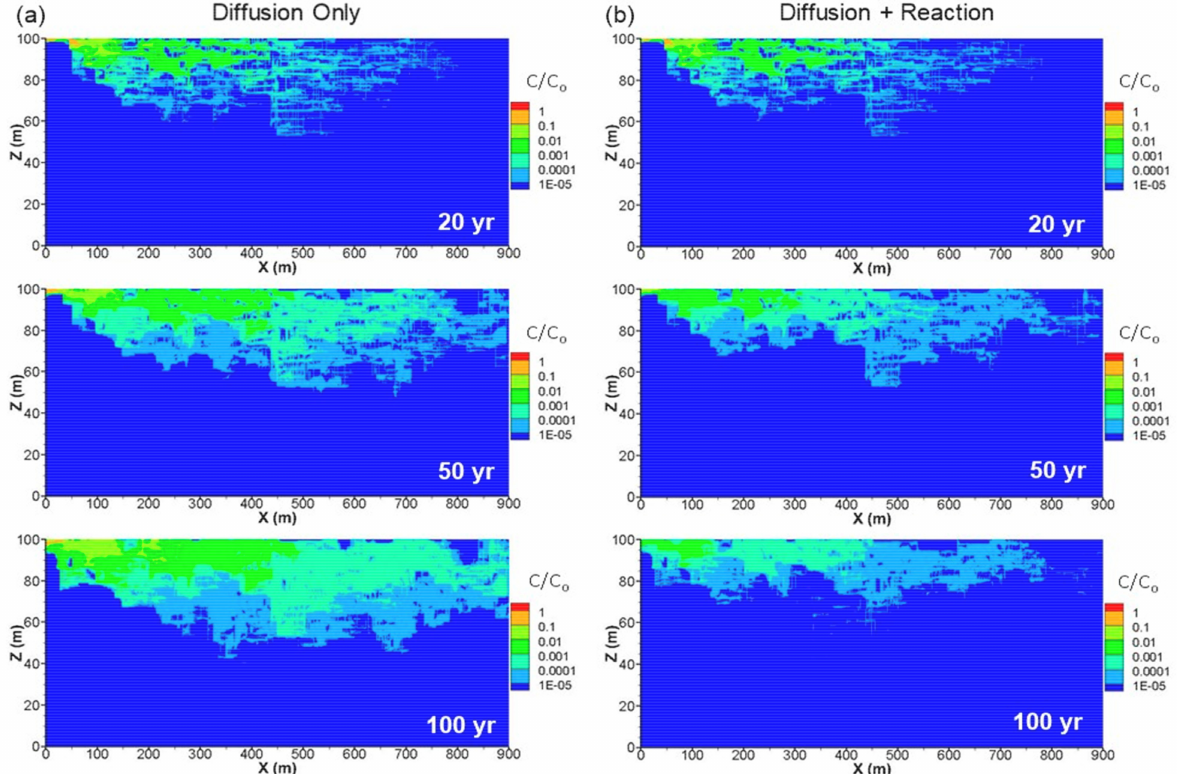
Figure 10. DFM simulated plumes at 20, 50 and 100 years for conditions of ( a ) diffusion only, and ( b ) diffusion and reaction that represents Cr ( VI ) loss in the matrix due to precipitation (simplified as first-order decay with t 1/2 = 20 years). The source is finite with a stepped decline (described in the text) representing the known release in 1983 and assumptions for source